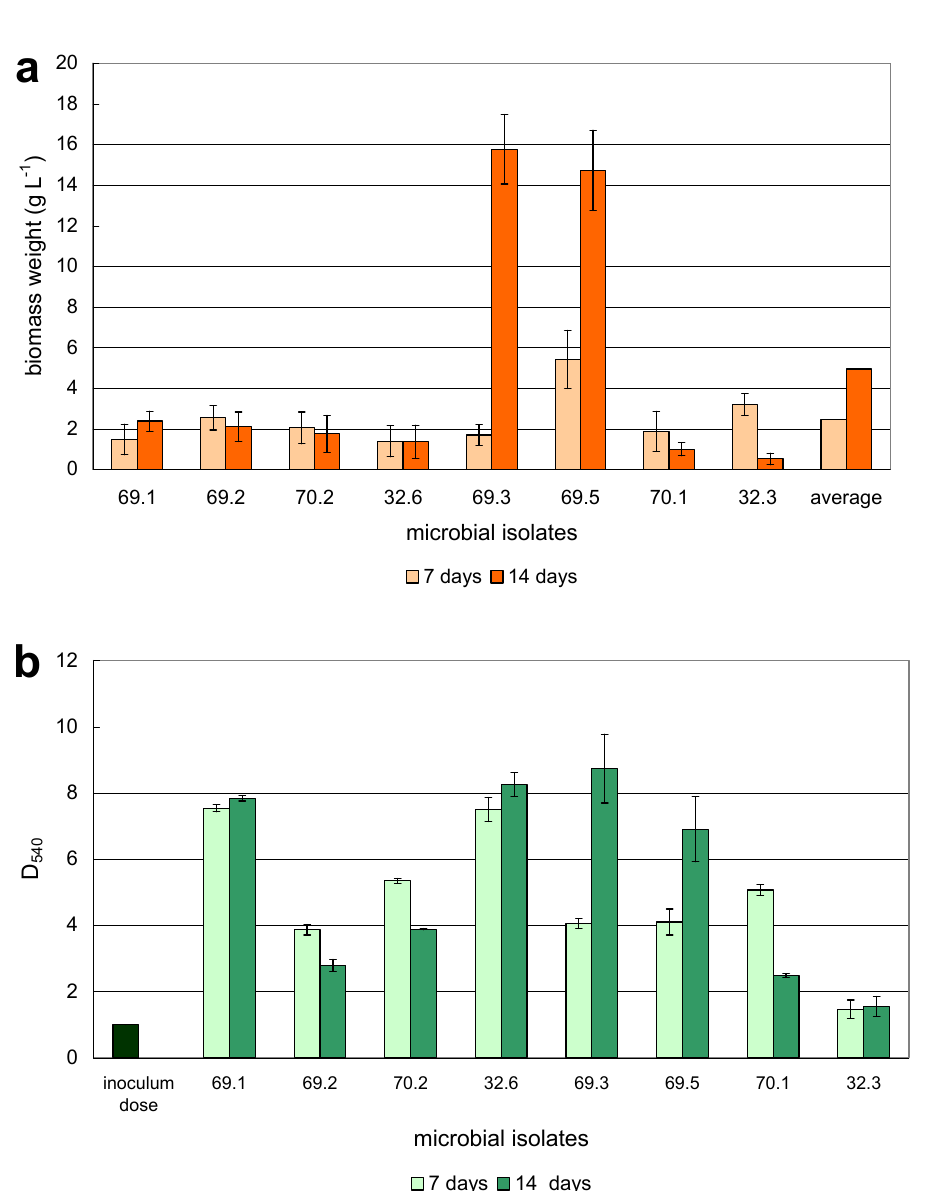
Figure 1. Growth indicators of microbial isolates when cultured in a liquid medium with Fe (II): ( a ) biomass increase by raw weight (mean ± S.D., n = 15; p ≤ 0.05); ( b ) absolute biomass increase (mean ± S.D., n = 9; p ≤ 0.05).